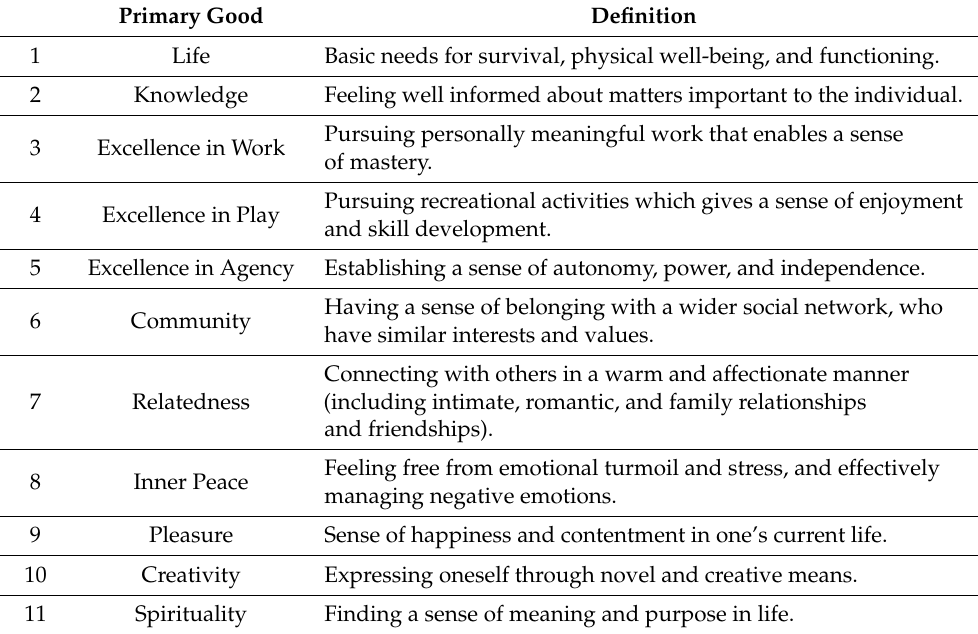
Table 1. Definitions of 11 Primary Goods, according to the